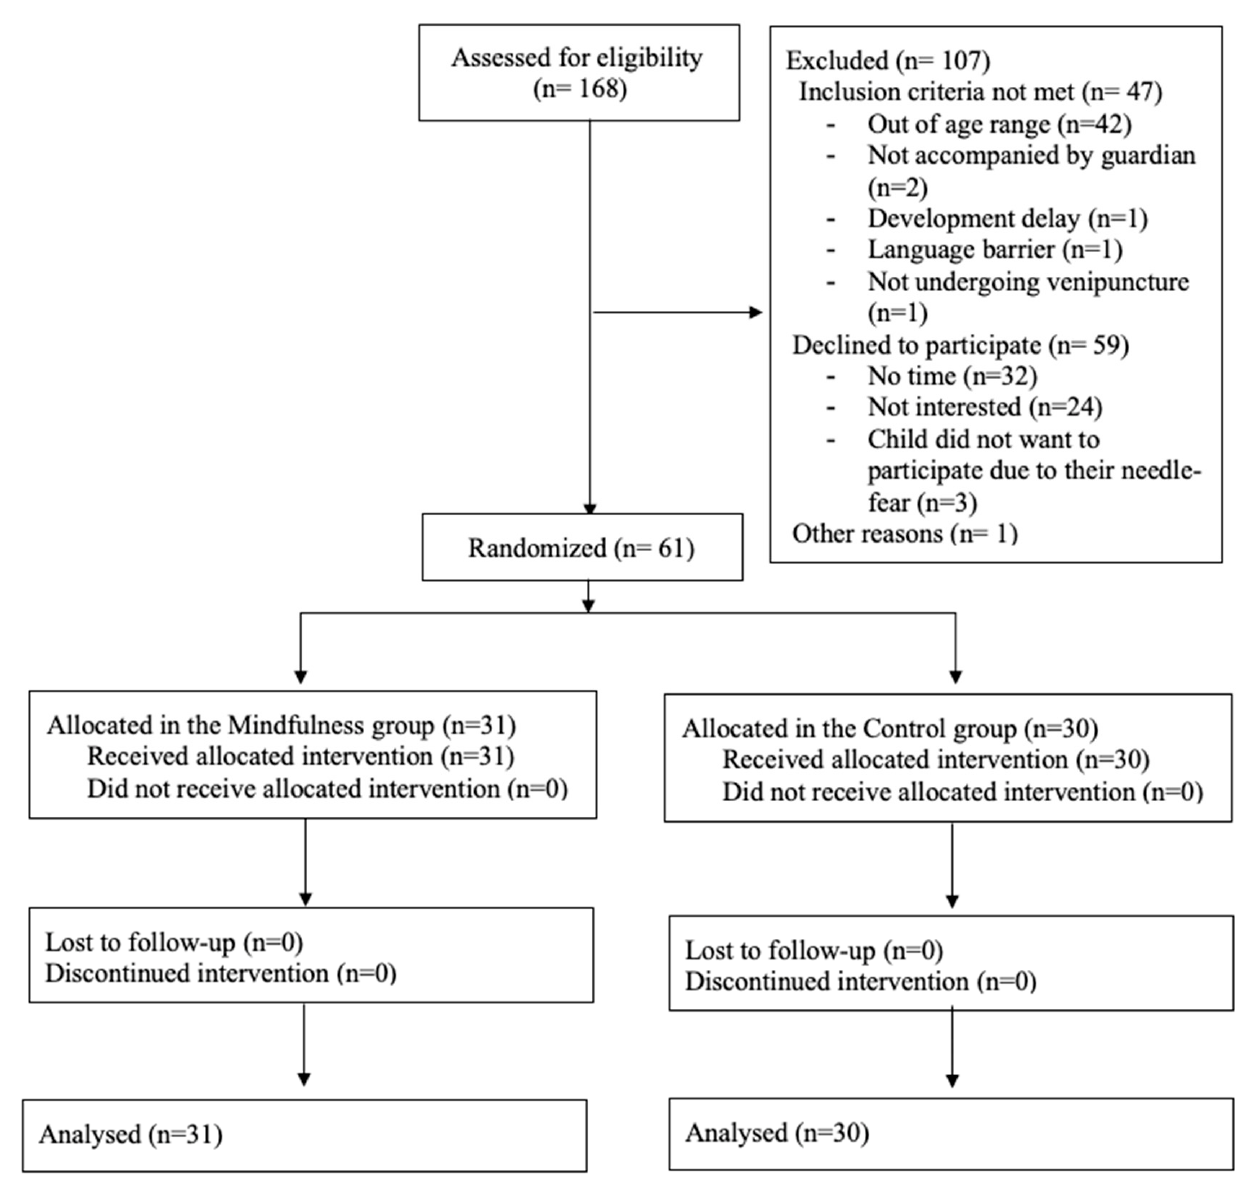
Figure 1. CONSORT Flow Diagram for the trial.